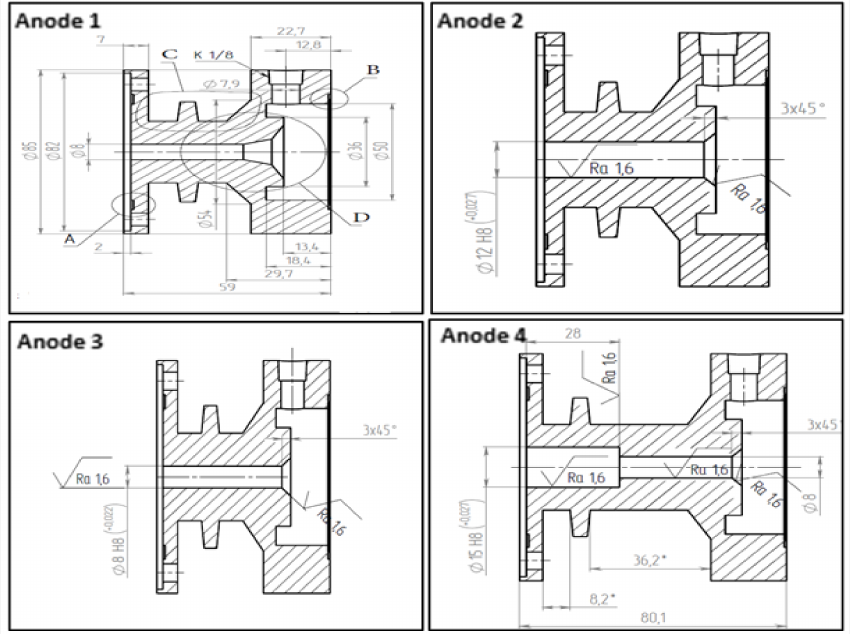
Figure 7. Four different designs of the anode from side